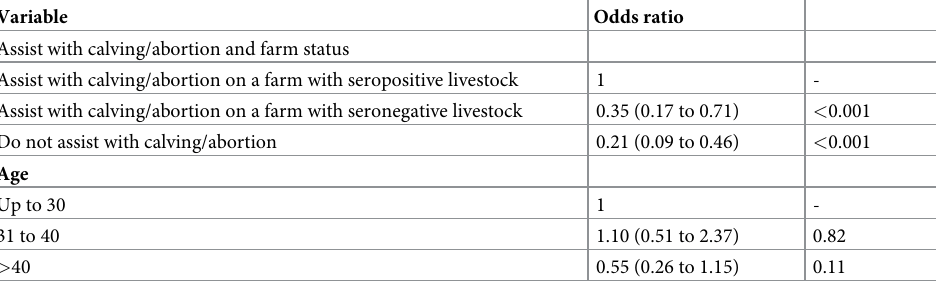
Table 8. Final multivariate model for all variables associated with Brucella seropositivity in people in direct con- tact with livestock, including farm status, using logistic regression with village included as a random effect. Variable Odds